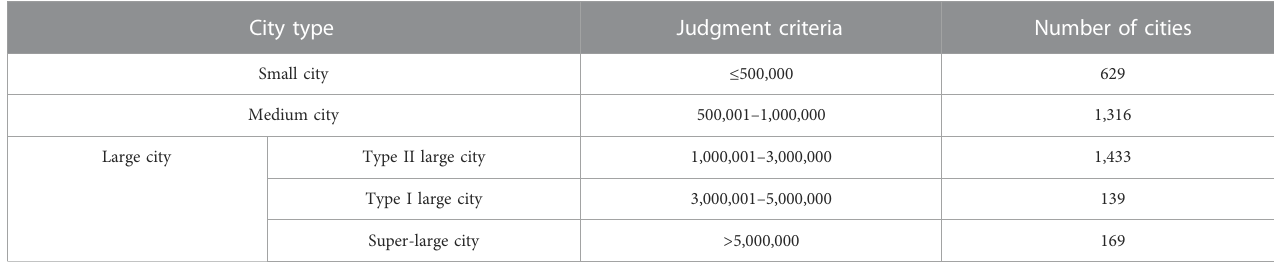
TABLE 8 Urban scale